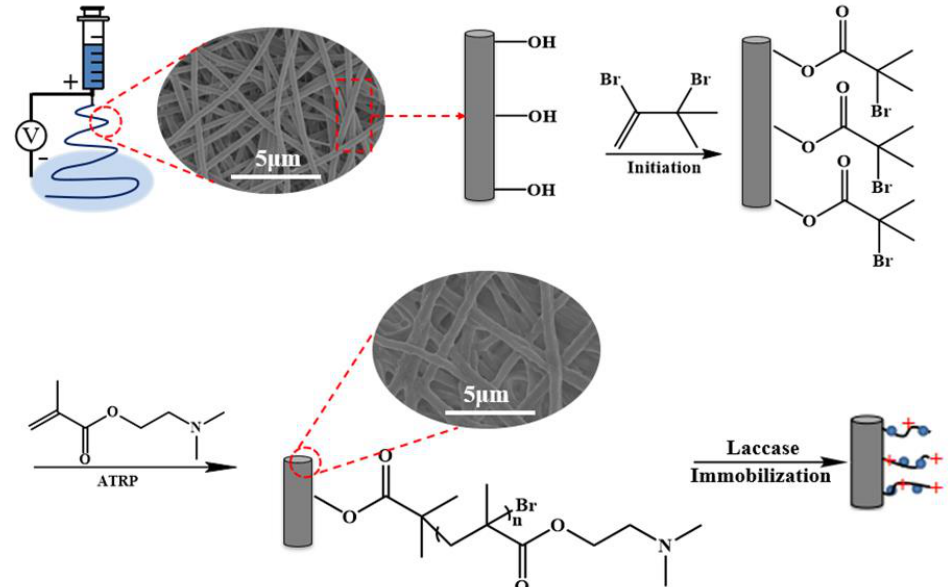
Figure 1. Schematic showing the electrospinning, the initiation of the electrospun regenerated cellulose (RC) nanofiber membrane, and the subsequent surface-grafting with poly 2-(dimethylamino) ethyl methacrylate (DMAEMA) chains via atom transfer radical polymerization (ATRP), as well as the immobilization of laccase on RC-poly (DMAEMA).